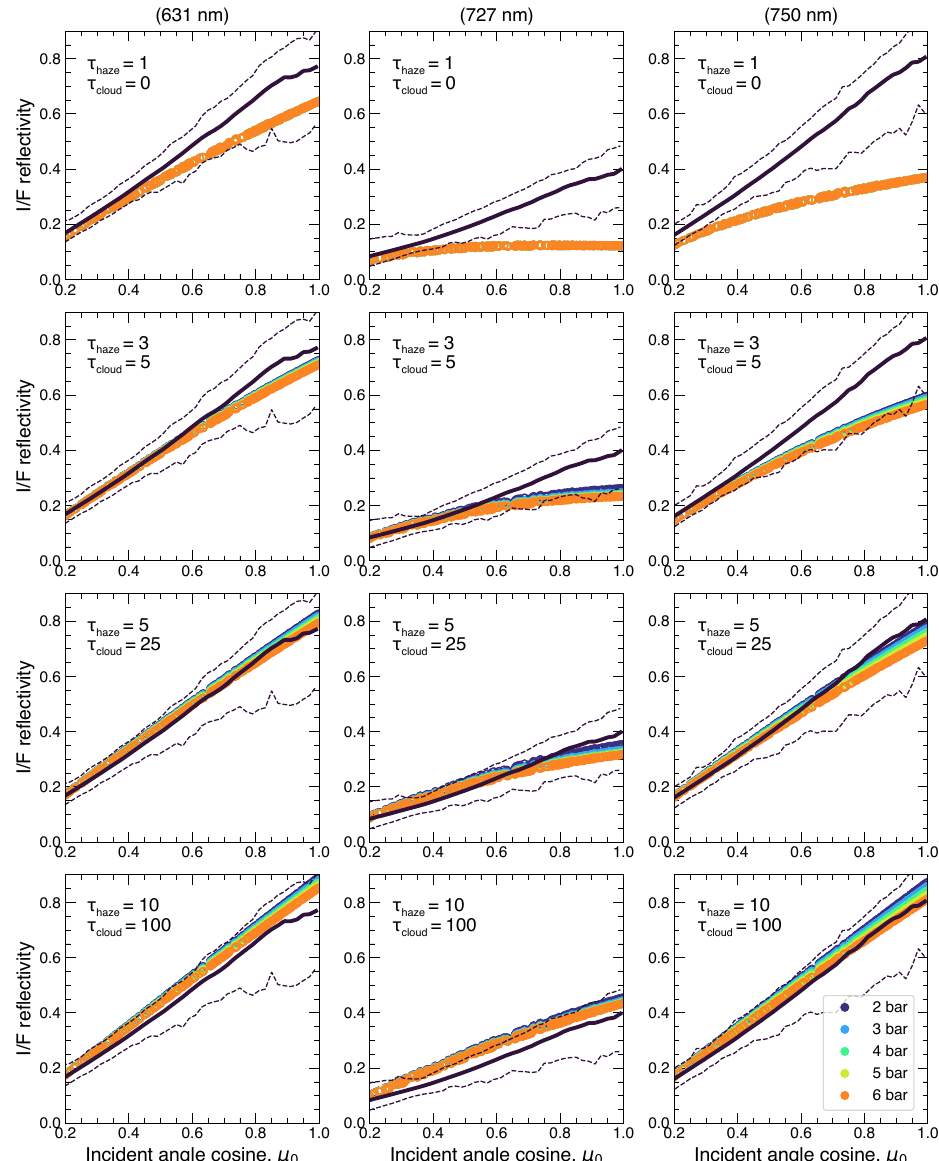
Figure 12. Comparison between observations (black: I / F in 727-nm and continuum filters) and models (colors) constrain the range of aerosol opacities on Jupiter in a global sense. Observed data from Figure 1 are shown in black (solid for the mean and dashed for the minimum and maximum values) as a function of solar incidence angle cosine. Data from across the disk have been sorted only by µ 0 , ignoring latitude, longitude, and type of feature to show the full range of variation over the image. Additional panels can be viewed in Figures S13–S17. The closest match to minimum I / F on the disk (lower dashed line) is the τ haze = 1, τ cloud = 0 case (top row) for 631 nm, and τ haze = 3, τ cloud = 5 for 727 nm and 750 nm. Mean global values are best matched by τ haze = 5, τ cloud = 25 (third row), and maximum reflectivities are best matched by τ haze = 10, τ cloud = 100 (bottom row). Colors correspond to deep cloud pressure levels from 2 bar (blue) to 6 bar (orange). The mean I / F values (solid black lines in Figure 12) are best fit by the middle row with τ haze = 5 and τ cloud = 25. Here, the model suggests some sensitivity to the deep cloud base level p cloud (with colored points shifting from blue to orange as cloud level increases from 2 to 6 bar). For 727 and 750 nm, the mean I / F center-to-limb curve is best fit when the deep cloud opacity is located at 2